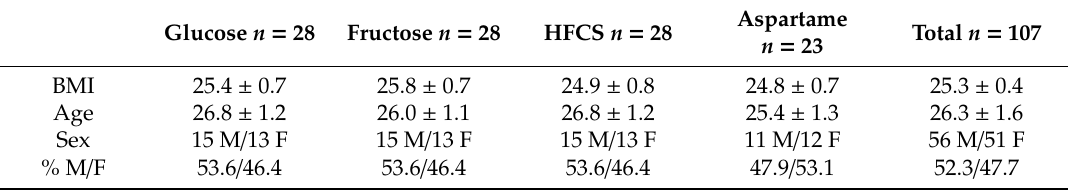
mass index; HFCS, high fructose corn syrup.